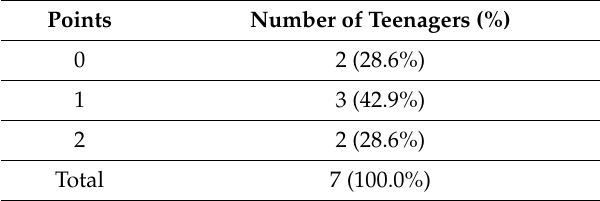
Table 3. Ranking of points obtained by di ff erent teenagers.